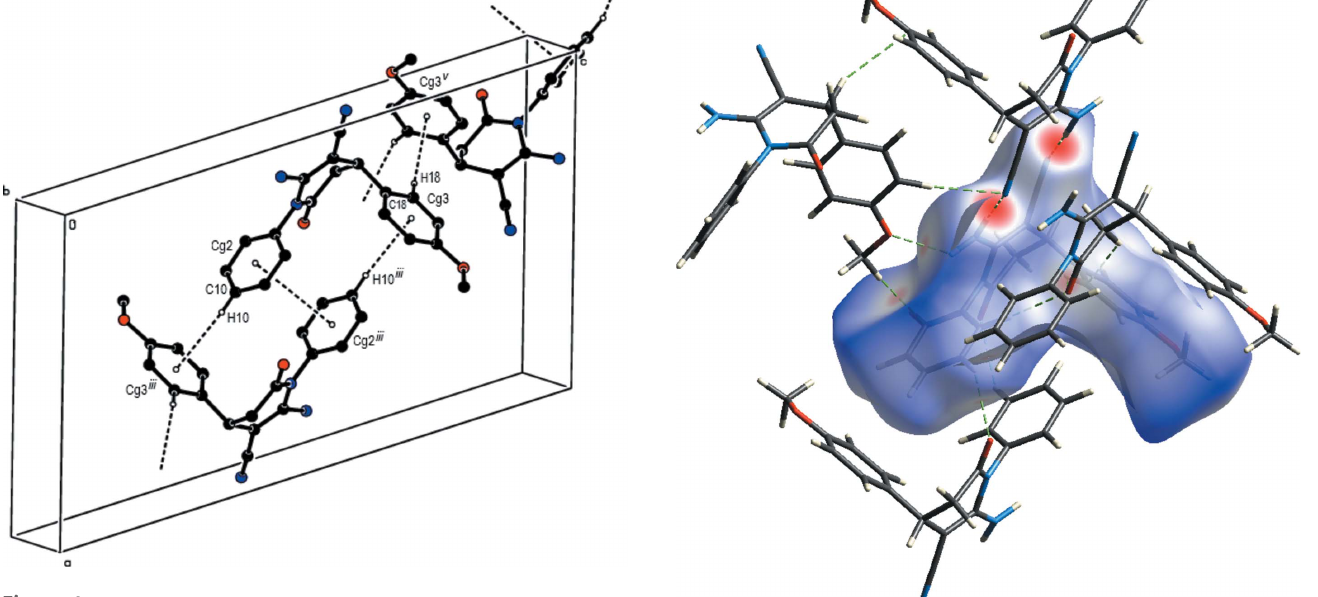
Figure 4 Figure 6 A general view of the C—H (cid:2)(cid:2)(cid:2) (cid:2) interactions and (cid:2) – (cid:2) stacking Hirshfeld surface mapped over d norm showing the N—H (cid:2)(cid:2)(cid:2) N, N—H (cid:2)(cid:2)(cid:2) O interactions in the crystal packing of the title compound [symmetry and C—H (cid:2)(cid:2)(cid:2) O intermolecular contacts. codes: (iii) (cid:4) x + 1, (cid:4) y + 1, (cid:4) z + 1; (v) (cid:4) x + 1 , y + 1 , (cid:4) z + 3 ]. 2 2 2 Crystal Explorer 17 (Turner et al. , 2017). The Hirshfeld surface was calculated using a standard (high) surface resolution with the three-dimensional d surface plotted over a fixed colour norm scale mapped over the range (cid:4) 0.4835 (red) to 1.8469 (blue) mapping indicates that strong hydrogen- a.u. The d norm bonding interactions, such as N—H (cid:2) (cid:2) (cid:2) N, N—H (cid:2) (cid:2) (cid:2) O and C— H (cid:2) (cid:2) (cid:2) O hydrogen bonds (Tables 1 and 2), appear to be the